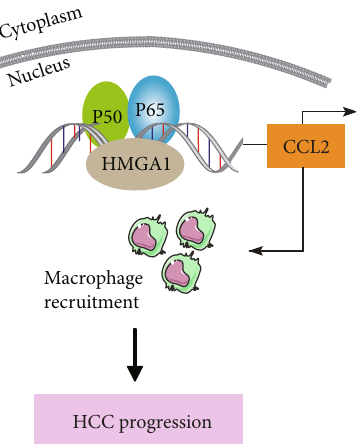
Figure 5: Mechanism model for HMGA1-mediated CCL2 expression in HCC. HMGA1 is located in the nucleus and functions together with NF- κ B to induce CCL2 expression. Furthermore, CCL2 recruits macrophages to the tumor microenvironment and leads to tumor